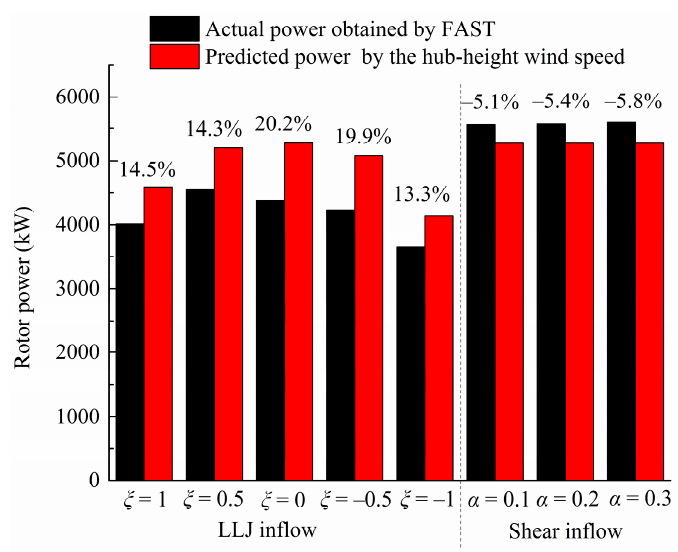
Figure 7. Comparison between actual results and predicted results of the rotor power under different inflow conditions. The actual result was obtained using FAST, and the predicted result was calculated using Equation (11). The value indicates the relative error of the rotor power prediction.